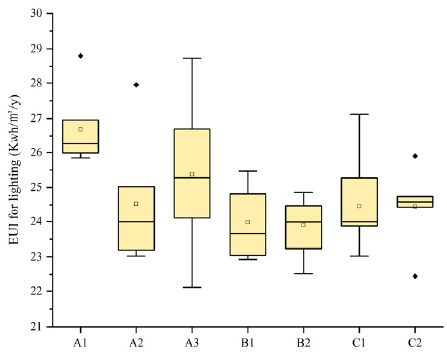
Figure 19. Distribution characteristics of EUI for lighting in different typologies of office blocks.